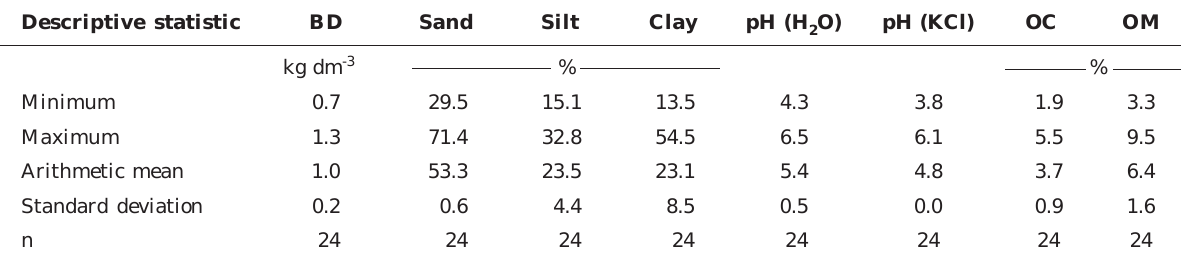
Table 1. Statistical summary of soil variables